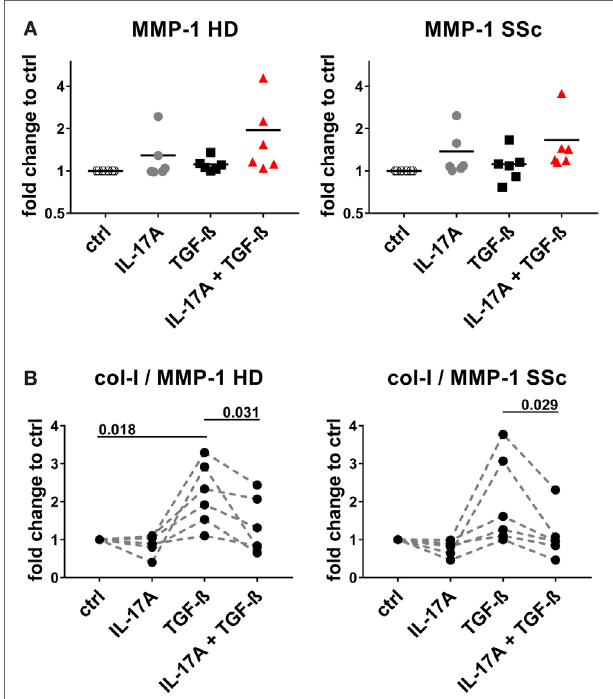
FigUre 8 | IL-17A decreases the col-I to MMP-1 ratio enhanced by TGF- β . Primary human dermal fibroblasts from healthy donors (HD) (left panel) and systemic sclerosis (SSc) patients (right panel) were cultured in the presence of IL-17A (25 ng/ml), TGF- β (2.5 ng/ml), or their combination for 48 h, in 96-well plates, in triplicates. MMP-1 levels (a) were assessed by ELISA in culture supernatants. Results are expressed as fold change compared to spontaneous production in control (ctrl) cultures. Basal levels for MMP-1 were 15.71 ( ± 1.3) and 20.1 ( ± 2.3) ng/ml, in HD and SSc, respectively. (B) The ratio of col-I levels from Figure 7c to MMP-1 was calculated. Significance was assessed by paired t -test.